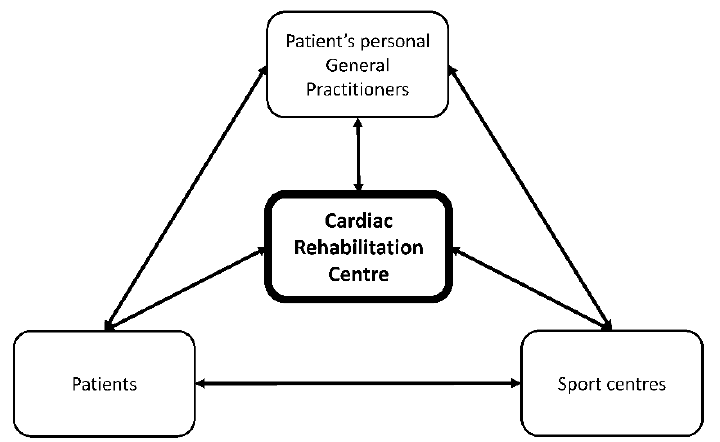
Figure 2. Organization of the hybrid cardiac rehabilitation model where the cardiac rehabilitation centre acts as the control tower of the whole rehabilitation.